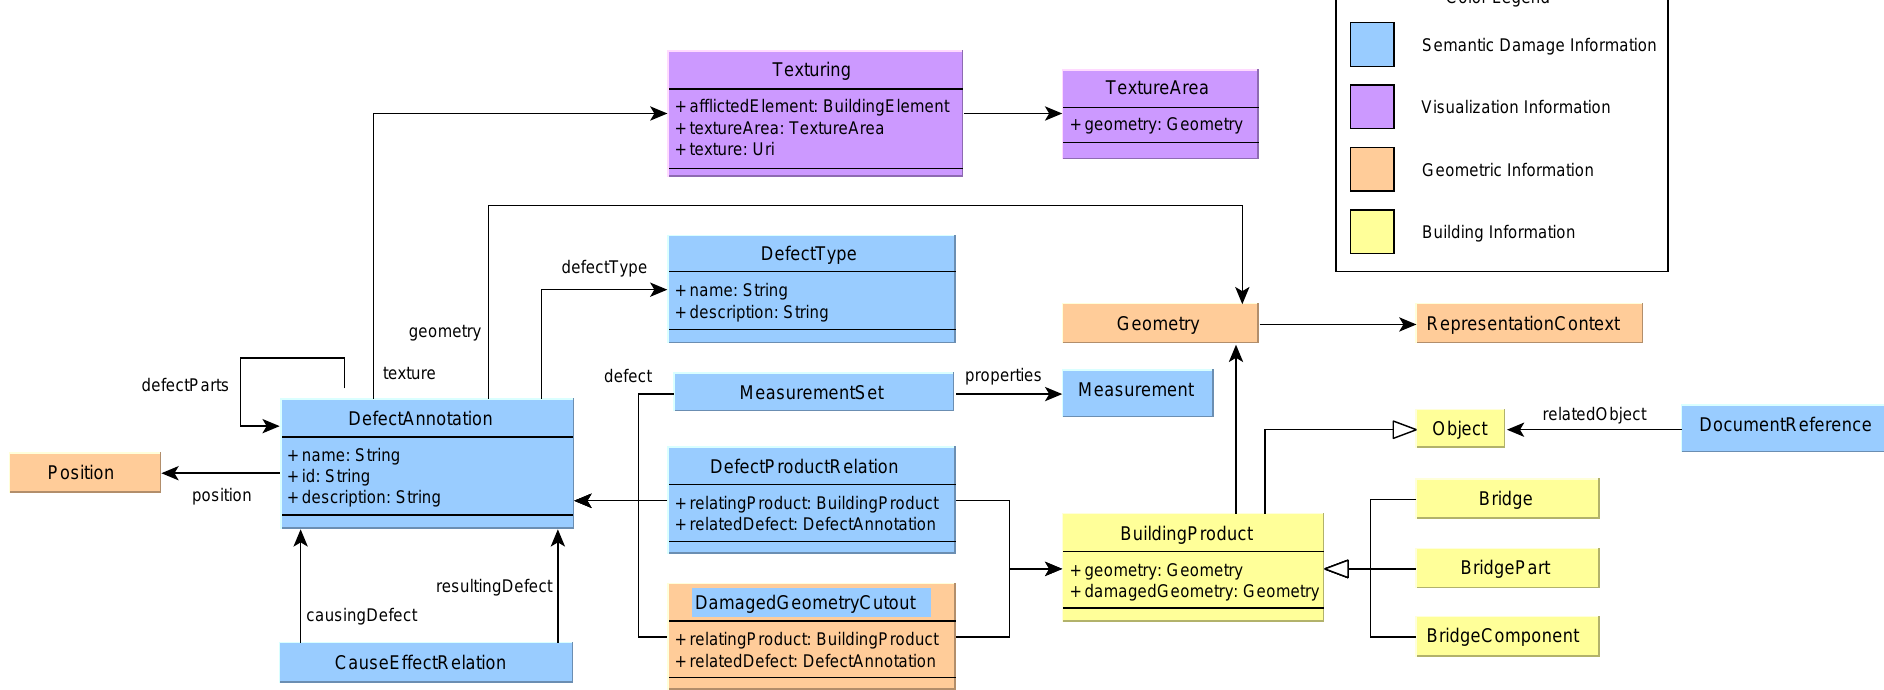
Figure 7. UML diagram of the data model. Semantic data is depicted in blue. Yellow elements refer to geometric data and green elements are related to visual data. The gray elements are related to the